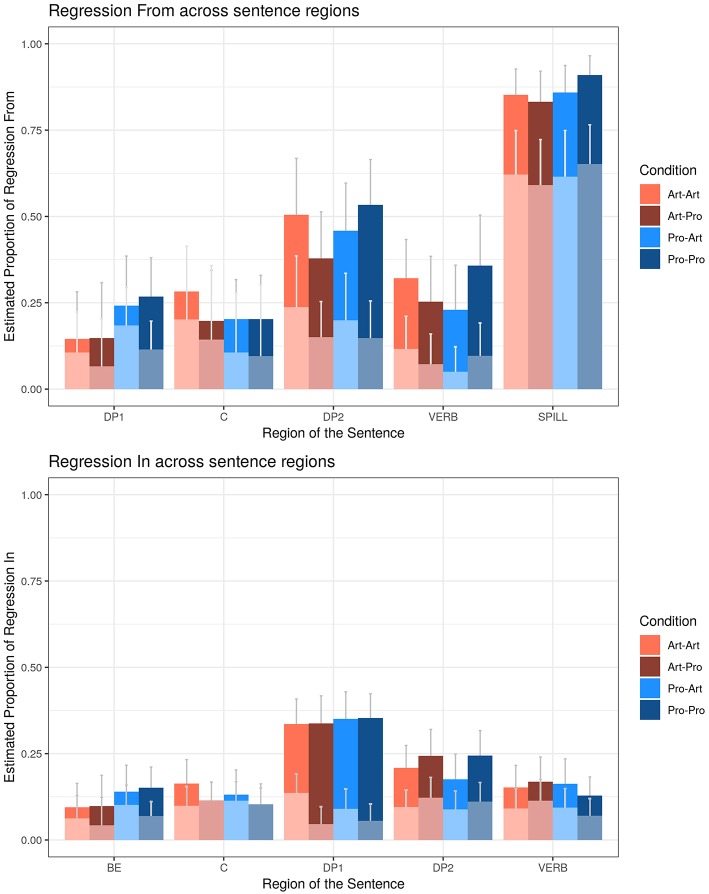
Estimated first (light shades) and total (full colors) regression probabilities (%) In and From the regions of interest. Error bars represent 95% confidence intervals around the models' estimates.